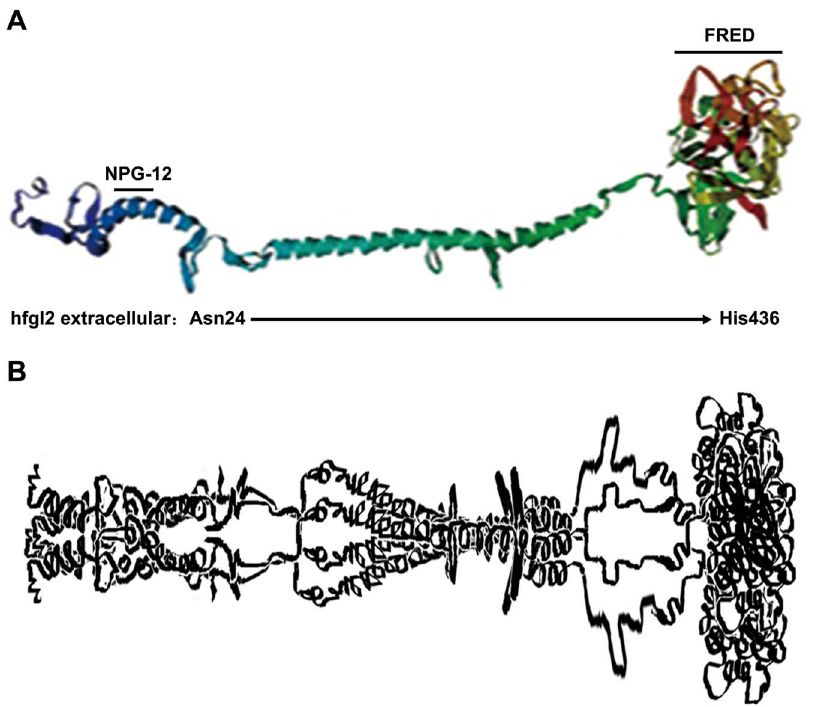
Figure 1. ModBase-MODEL prediction of the hfgl2 structure. (A) Prediction of hfgl2 protein structure was obtained from ModBase-MODEL website, and A4D1B8 was selected as the primary database link (http://modbase.compbio.ucsf.edu/modbase-cgi/search_form.cgi). NPG-12 and FRED domain are indicated by black bars. (B) Schematic illustration of tetrameric hfgl2 protein adapted from ModBase-MODEL analysis.